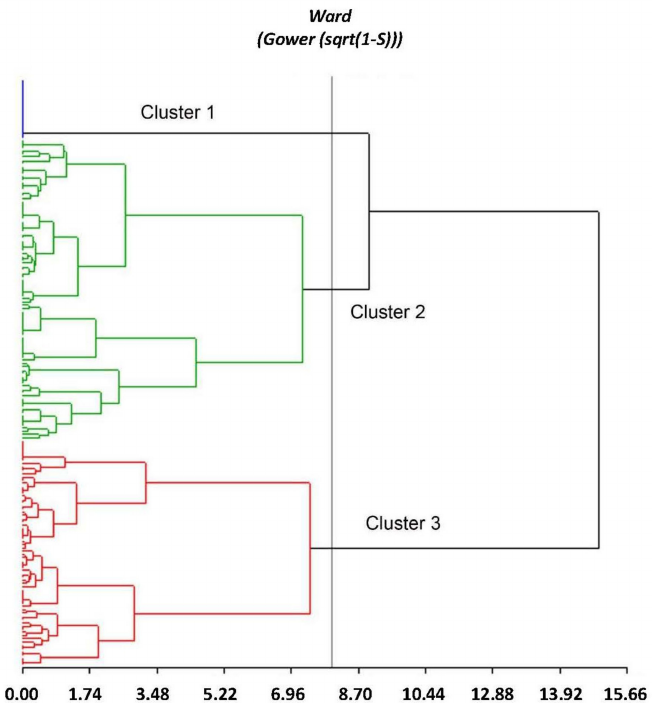
Figure 4. Dendrogram of the Ecuadorian cassava collection indicating three groups of accessions based on quantitative ecogeographic data using Ward’s method and Gower’s